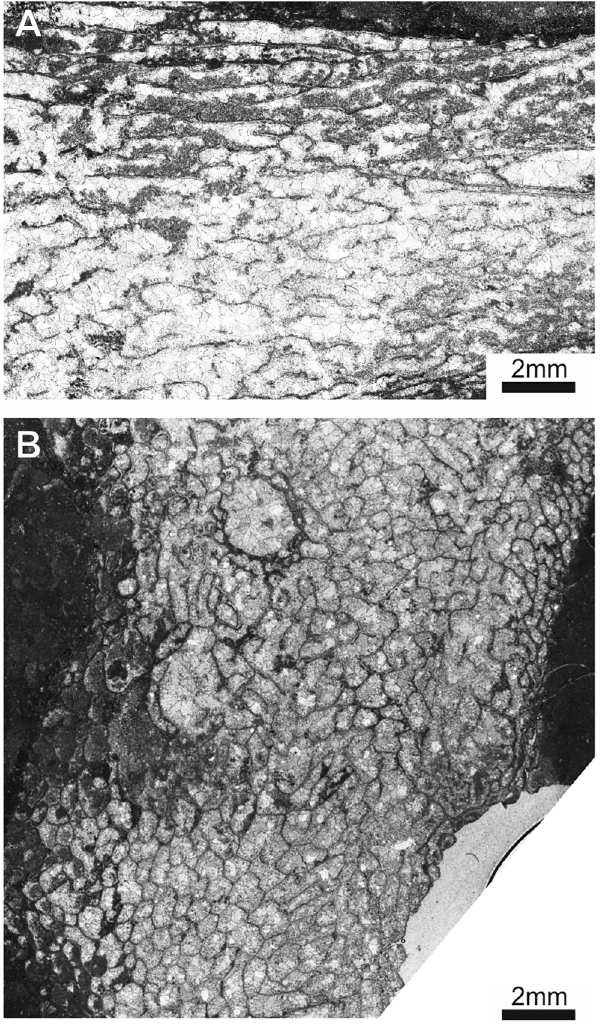
Fig 5. ?Alveolitidae indet. from Kowala Quarry, lithological set L, late Famennian. (A) section close to longitudinal. (B) section close to transverse. Specimen GIUS 3619 KK 251.